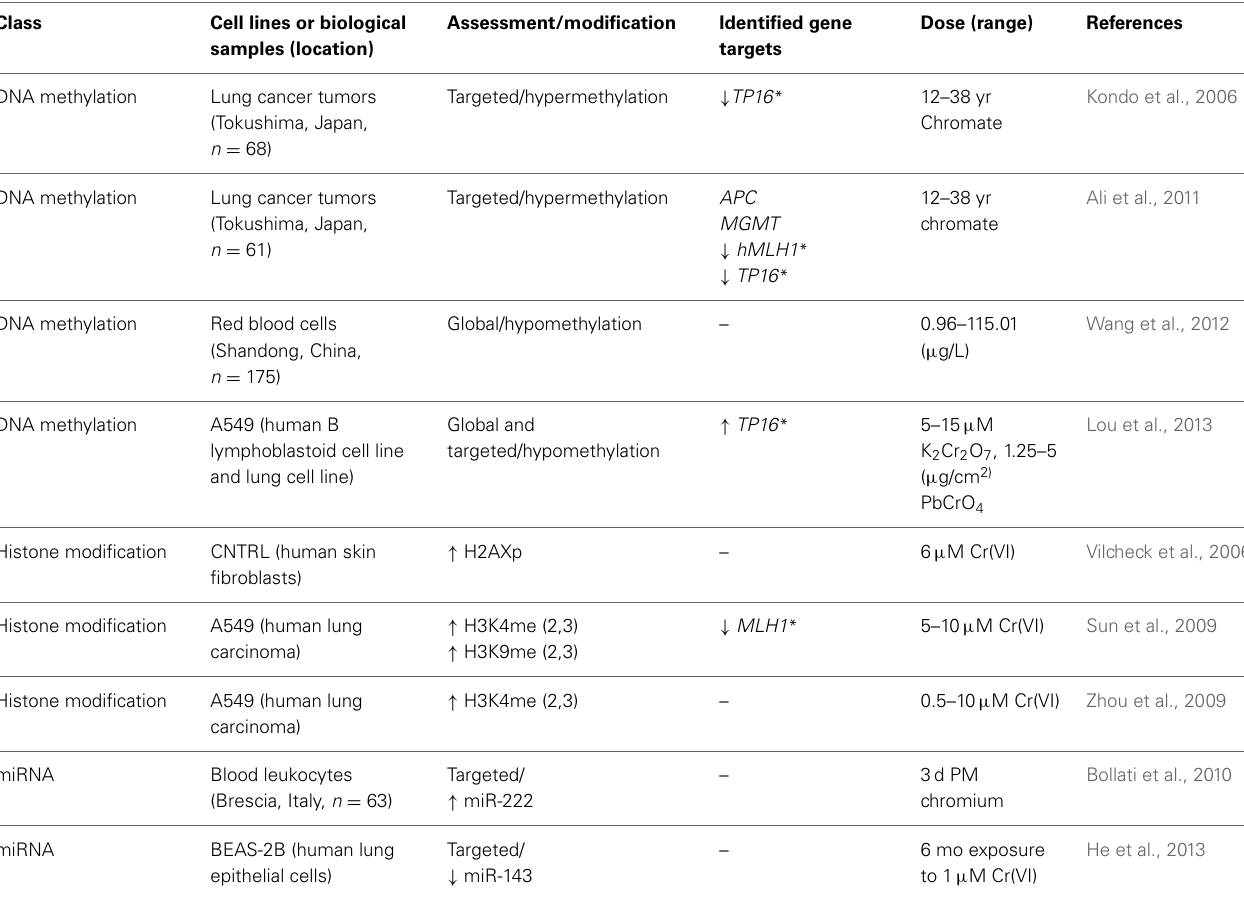
Table 5 | Epigenetic alterations induced by